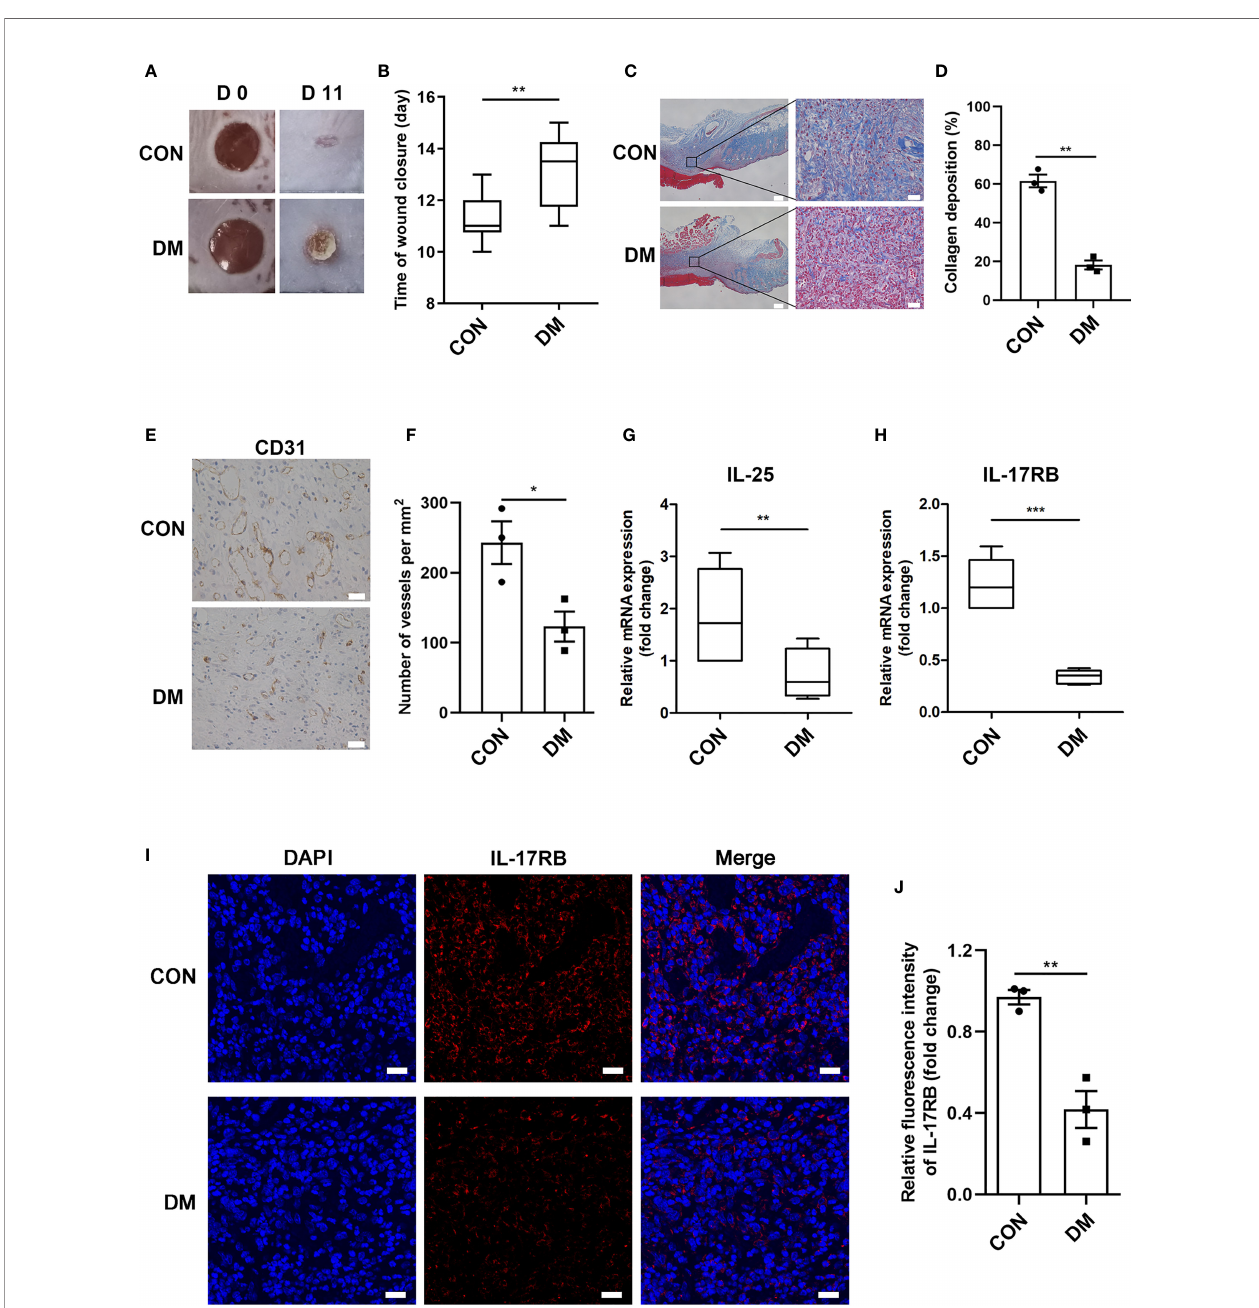
FIGURE 2 | Downregulation of IL-25-mediated-IL-17RB signaling contributes to the delay of wound healing in diabetic mice. 7-day wound biopsies within 2 mm of a wound edge were obtained from dorsal skin of control (CON) and diabetic (DM) mice. (A) Images of representative wounds on day 0 and day 11 after injury. (B) Quanti fi cation of time of wound closure (n = 5). (C) Representative images of Masson trichrome staining of dorsal skin sections from control and diabetic mice. Scale bars, 200 m m (left), 25 m m (right). (D) Quanti fi cation of collagen deposition in different groups (n = 3, three views for each sample). (E) Angiogenesis analysis by immunohistochemistry staining of CD31 in dorsal skin sections from control and diabetic mice. Scale bars, 25 m m. (F) Quanti fi cation of the vessel numbers is displayed in the graph (n = 3). (G, H) Relative mRNA expression of IL-25 and IL-17RB in the wound skin from control and diabetic mice (n = 3). (I, J) Representative immuno fl uorescent staining for IL-17RB (red) and DAPI (blue) in skin sections of wound edge from control and diabetic mice. Scale bars, 20 m m. Quanti fi cation of the IL-17RB protein expression in the mice skin is shown in the histogram in J (n = 3). * P < 0.05, ** P < 0.01, *** P <